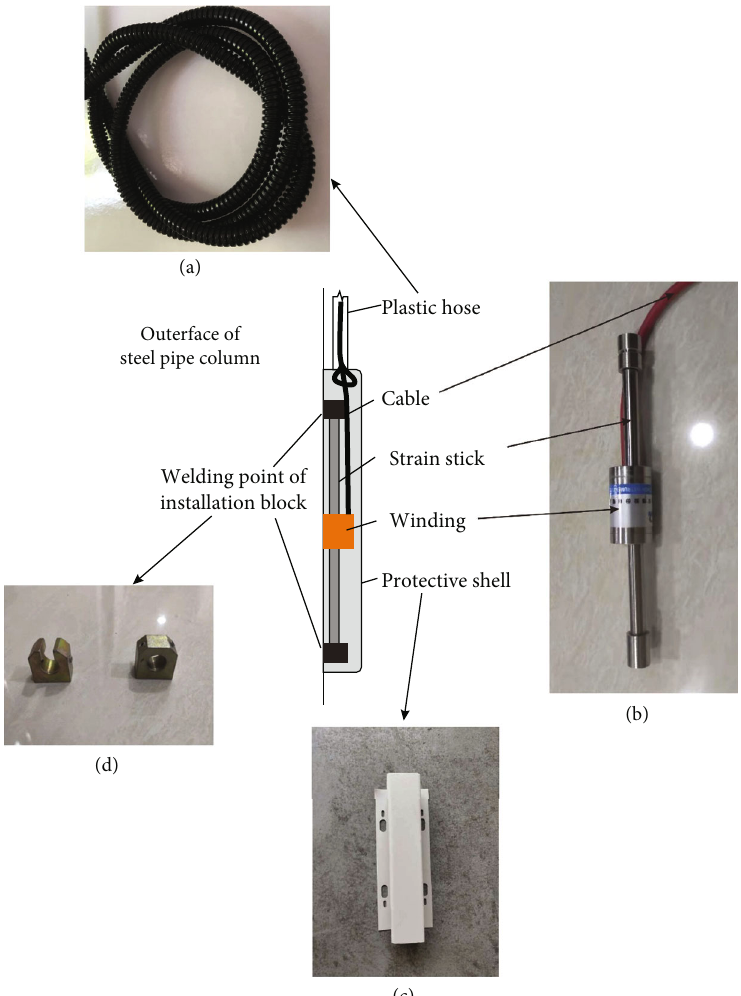
Figure 3: Strain gauge installation schematic diagram: (a) plastic hose, (b) surface strain gauge, (c) protective shell, and (d) installation